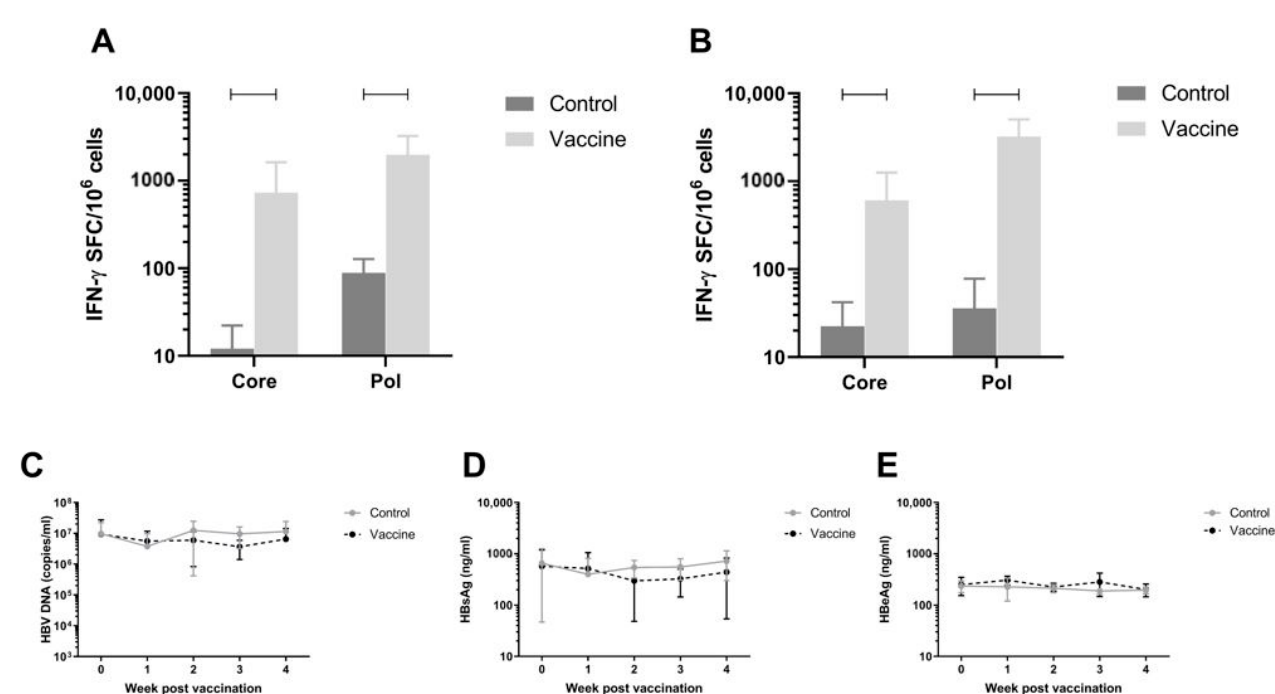
Figure 4. Immunogenicity and effect on viral parameters of vaccination with pDK-Core and pDK-Pol in AAV-HBV infected C57BL/6 mice. Core and Pol specific T-cell responses at day 56 after rAAV-HBV infection in ( A ) spleen and ( B ) intrahepatic lymphocytes after vaccination with pDK-Core and pDK-Pol or control (backbone only) plasmids at day 28 and 49 after infection (n = 8). Viral parameters ( C ) total HBV DNA (copies/mL), ( D ) HBsAg (ng/mL), and ( E ) HBeAg (ng/mL) were measured in the blood during the experiment. Infection, dosing, and sampling were performed as described in Materials and Methods. Statistical significance ( p ≤ 0.05) is indicated above the bars.